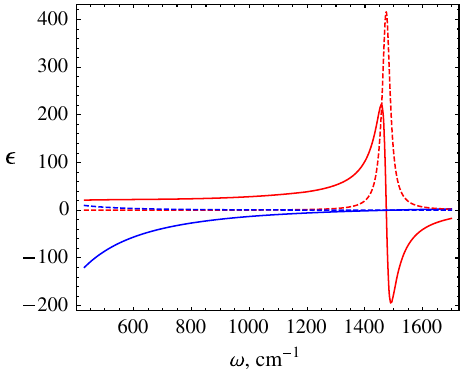
FIG. 3. The dielectric permittivity tensor of an n þ -In 0 Ga 0 As Al 0 In 0 As semiconductor superlattice . 53 . 47 . 48 . 52 metamaterial, with a 50% volume fraction of the doped semi- conductor with a plasma wavelength of 5 μ m. Blue and red lines correspond to the permittivities parallel and perpendicular to the normal to the layers. Real and imaginary parts of the permittivity are represented, respectively, by solid and dotted lines. For the metamaterial unit cell size of a ∼ 100 nm in the mid-IR fre- quency range, this effective medium description is valid as long as k=k 0 ≪ λ 0 =a ≃ 100 (see also Fig. 5).